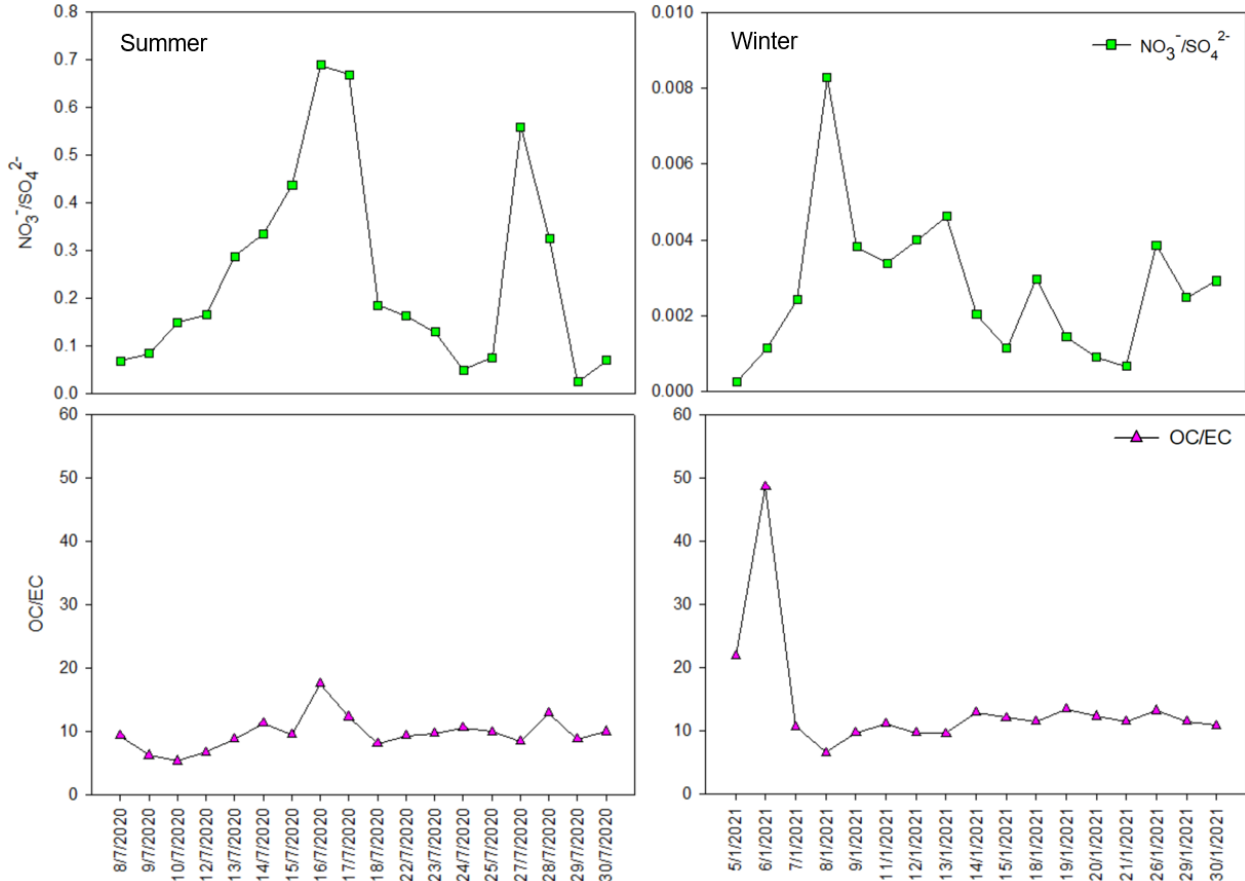
Figure 5. Daily variation of NO 3- /SO 42- and OC/EC mass ratio for the summer and winter periods. According to [43], atmospheric Mg 2+ and Ca 2+ usually originate from crustal sources (i.e., soil, construction, and re-suspended road dust). For the summer period, a slightly positive correlation between Mg 2+ and Ca 2+ was seen, which suggested that the sources contributing to Mg 2+ and Ca 2+ during this period might be different. However, for the win- ter period, a significant positive correlation for Mg 2+ and Ca 2+ was found, which suggested the common crustal sources for these cations. For sea salt aerosol, a low correlation for